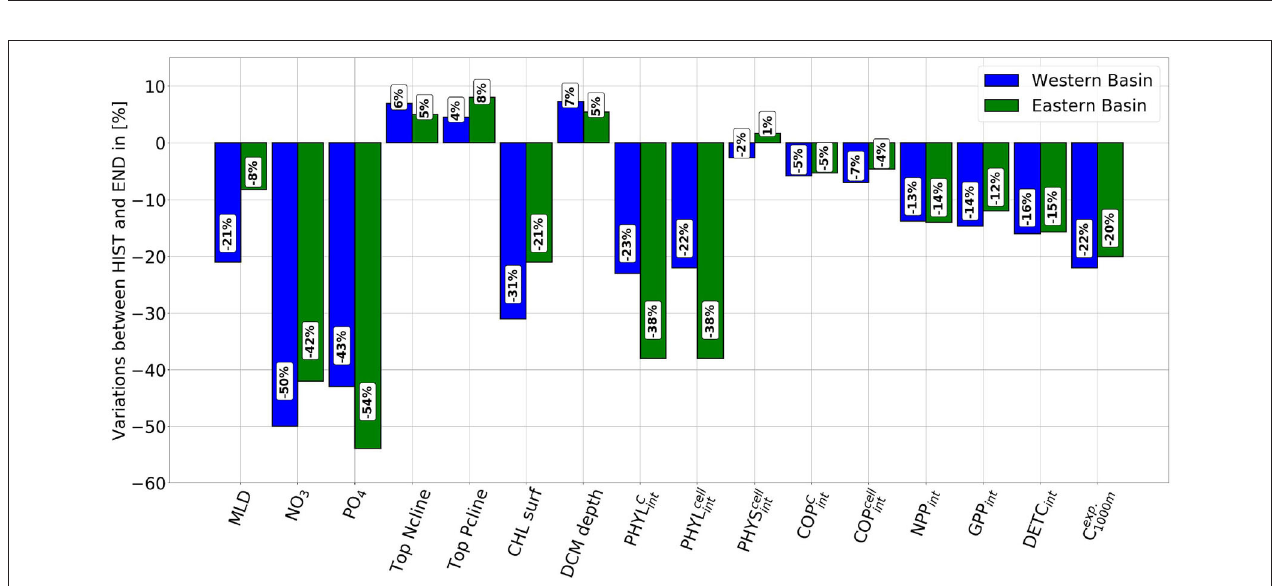
FIGURE 5 | Changes (in percent) of the main biogeochemical variables calculated by the model between the HIST (1986–2005) and the END (2081–2100) periods.